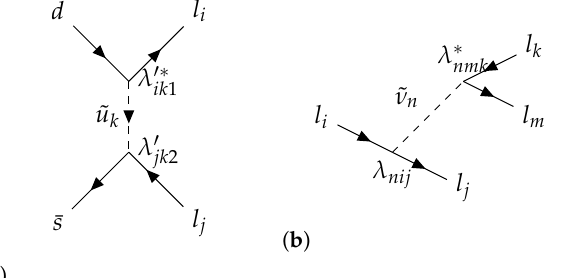
Figure 10. Examples of LFV tree-level diagrams in the supersymmetric SM with R-parity violation. ( a ) Diagrams contributing to the LFV meson decay K 0 → l i l j . ( b ) Diagrams contributing to the l i → l j l k l m